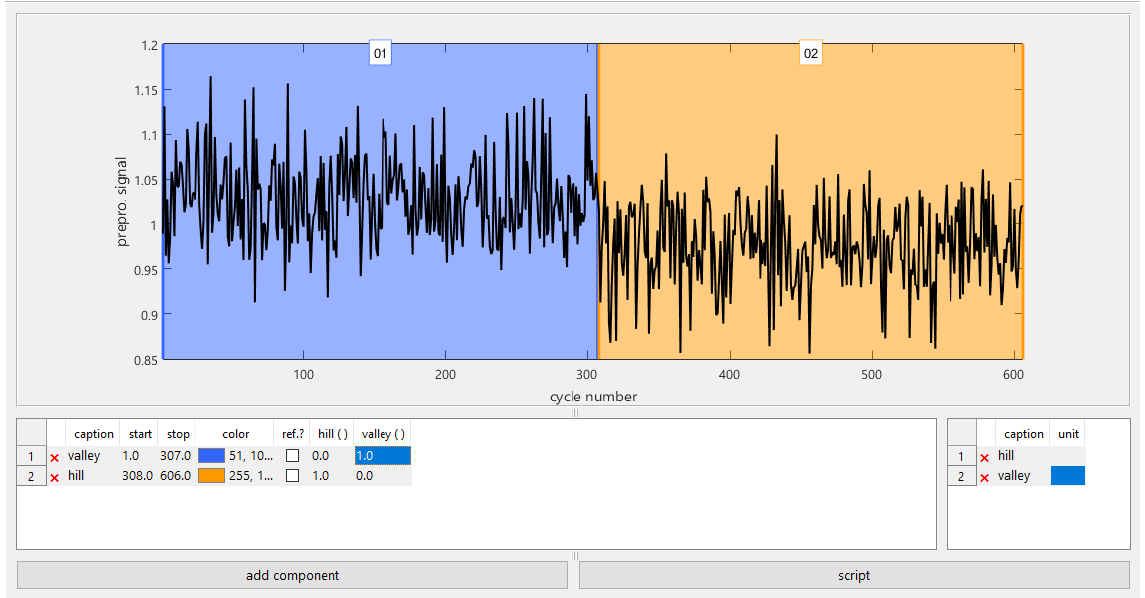
Figure 6. Module to select cycle ranges which pool cycles with the same underlying conditions.